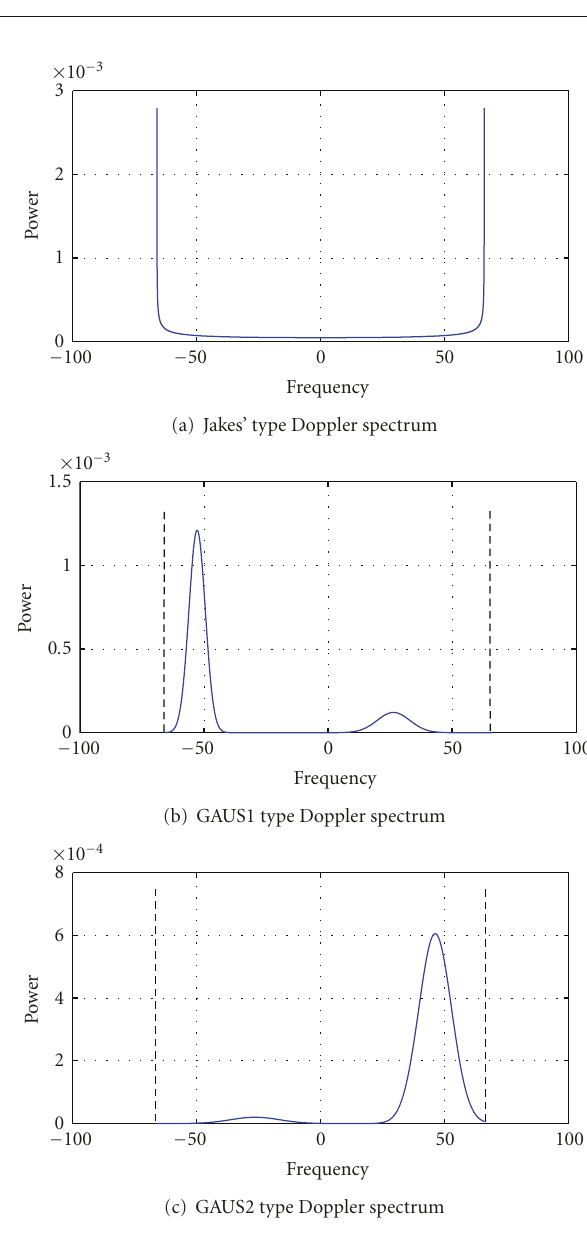
Figure 2: Di ff erent Doppler spectra that are encountered in di ff erent environments for 900 MHz carrier frequency and a mobile speed of 22 m/s. Vertical dashed lines in Figures 2(b) and 2(c) correspond to maximum Doppler frequency, which is 66